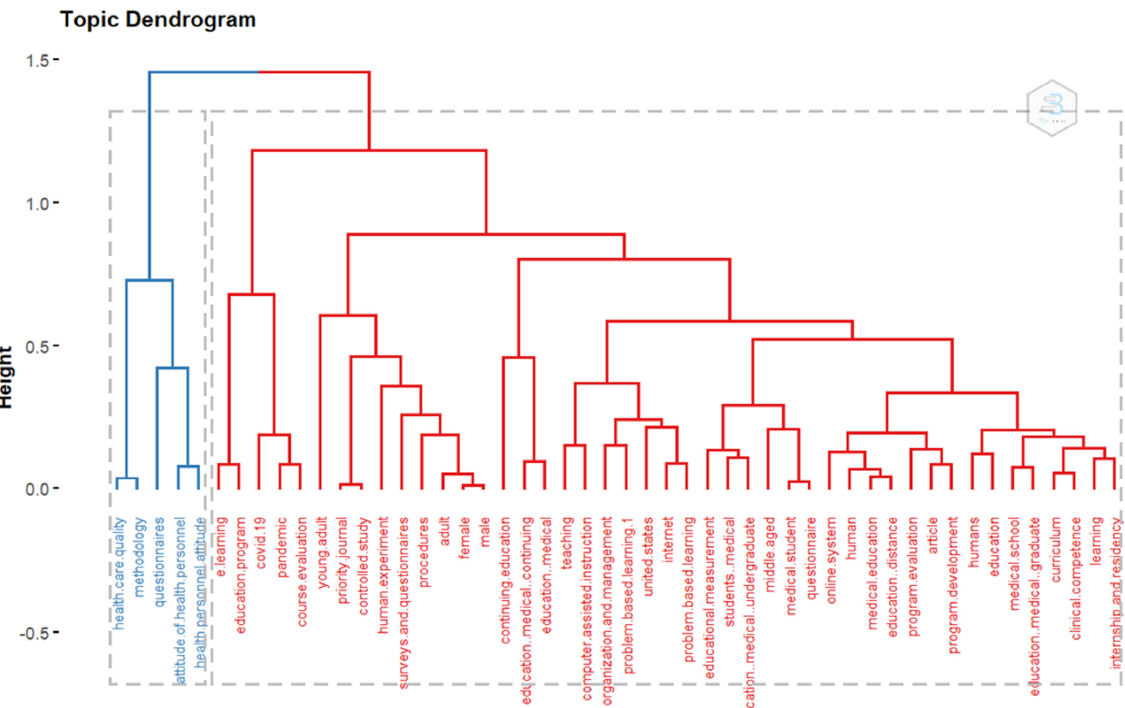
Figure 13. Dendrogram of hierarchical cluster analysis of keywords displaying the closeness of association between domain keywords.